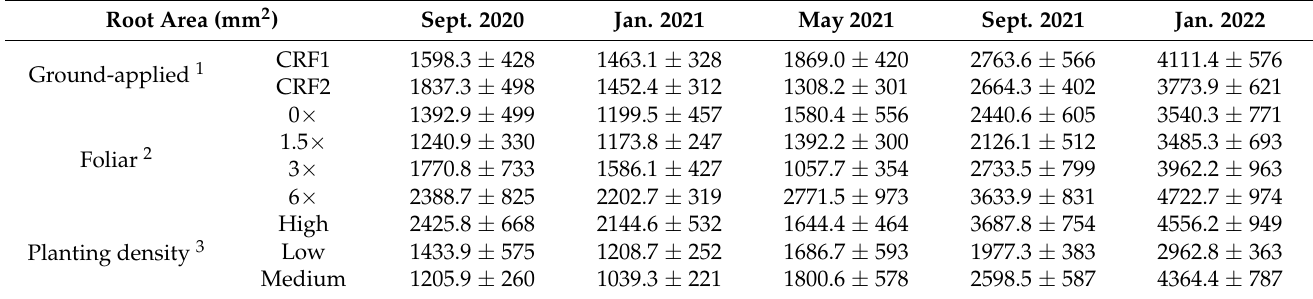
Table 8. Total root area of ‘Ray Ruby’ grapefruit grafted on ‘Kuharske’ citrange planted in flatwood soils located in Fort Pierce, FL, USA, and treated with ground-applied fertilizer, foliar fertilizer and different planting densities from September 2020 to January